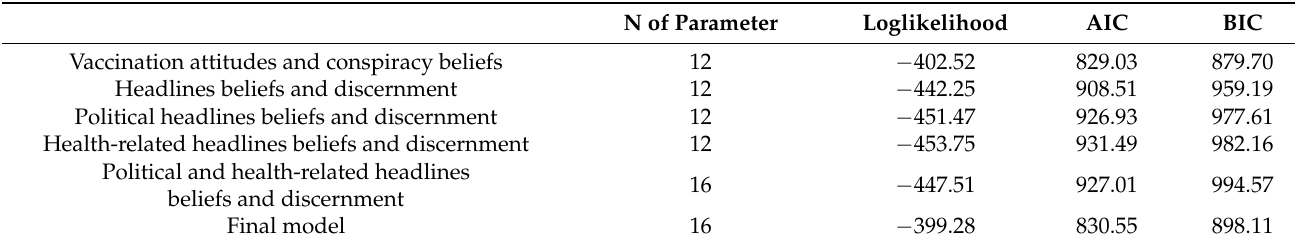
Table 4. Model fit